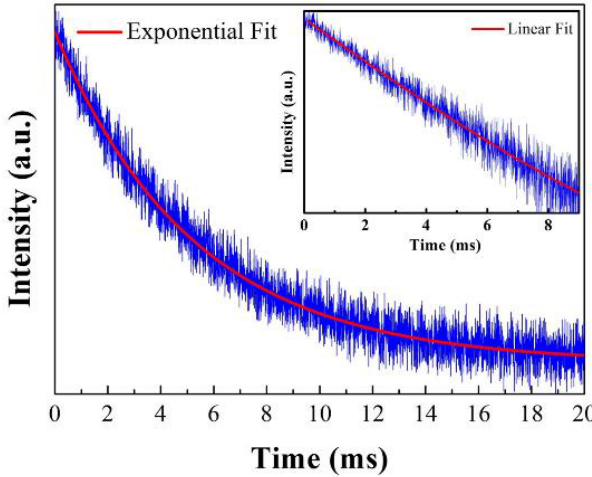
Figure 5. RT fluorescence lifetime fitted by exponential functions. Inset: the linear fitted lifetime with log (intensity) vs. time. (Source: [34], © 2015 Optica Publishing Group, Washington, DC, USA).